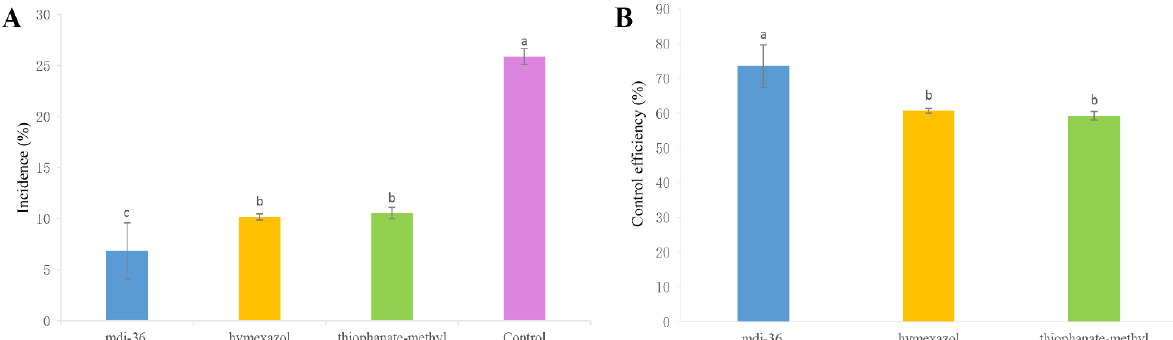
Figure 2. Efficacy evaluation of antagonistic B. velezensis mdj-36 against Fusarium oxysporum -induced rice seedling blight for ten days. ( A ) incidence, and ( B ) control efficiency. All values were expressed as mean ± SD. Varying significant differences were noticed between tested strains ( p < 0.05).